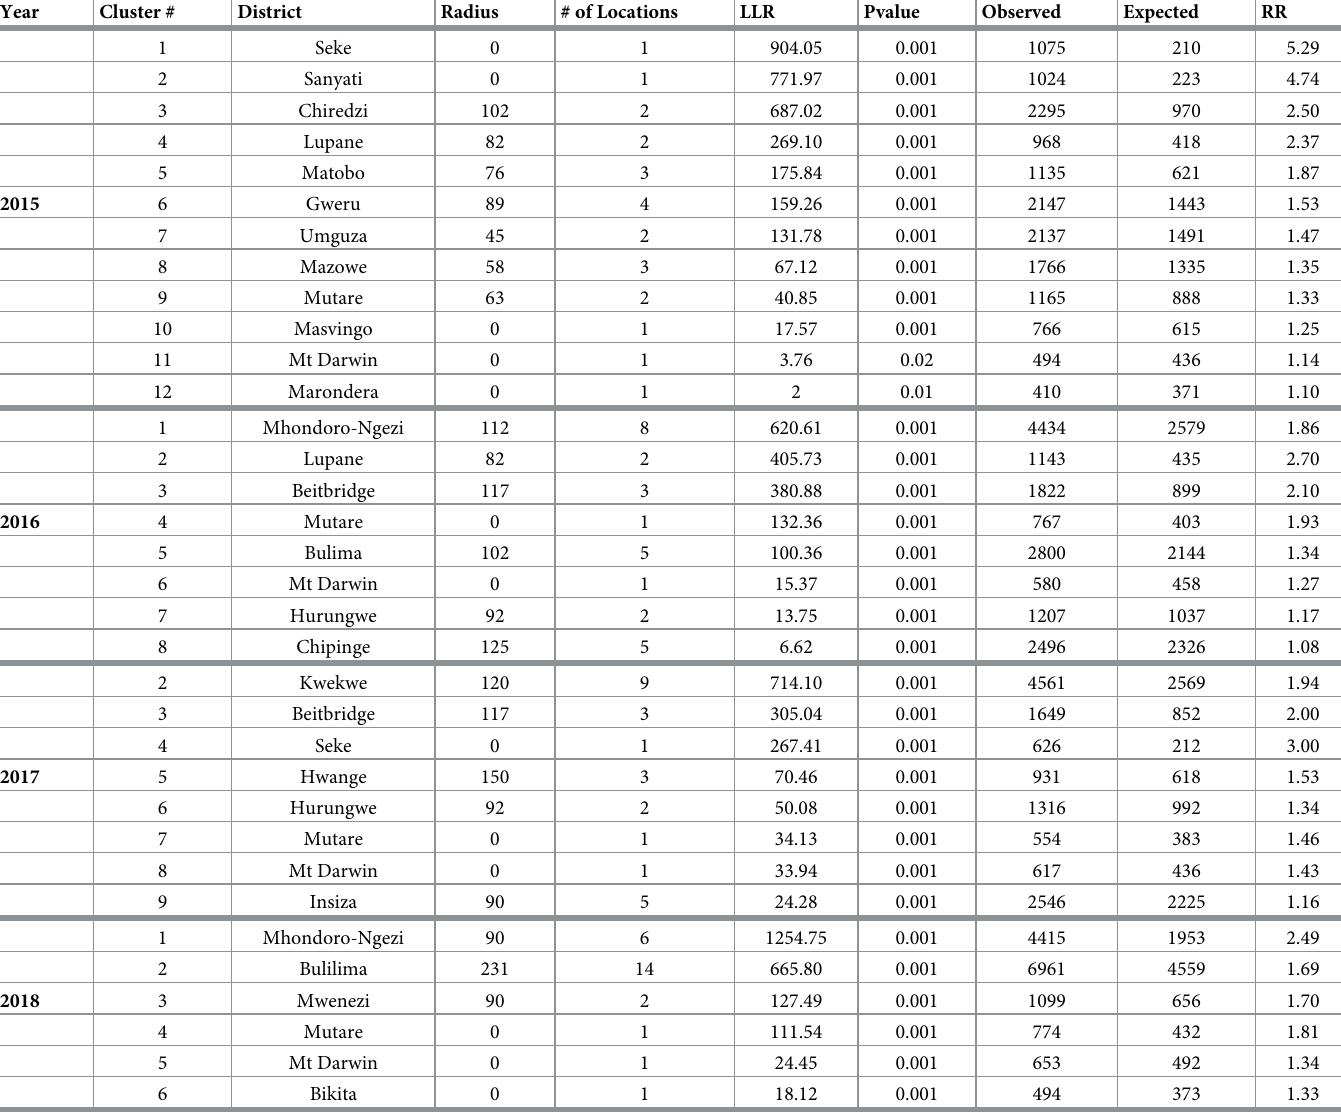
Table 2. Significant spatial clusters of TB in Zimbabwe based on maximum reported cluster size from